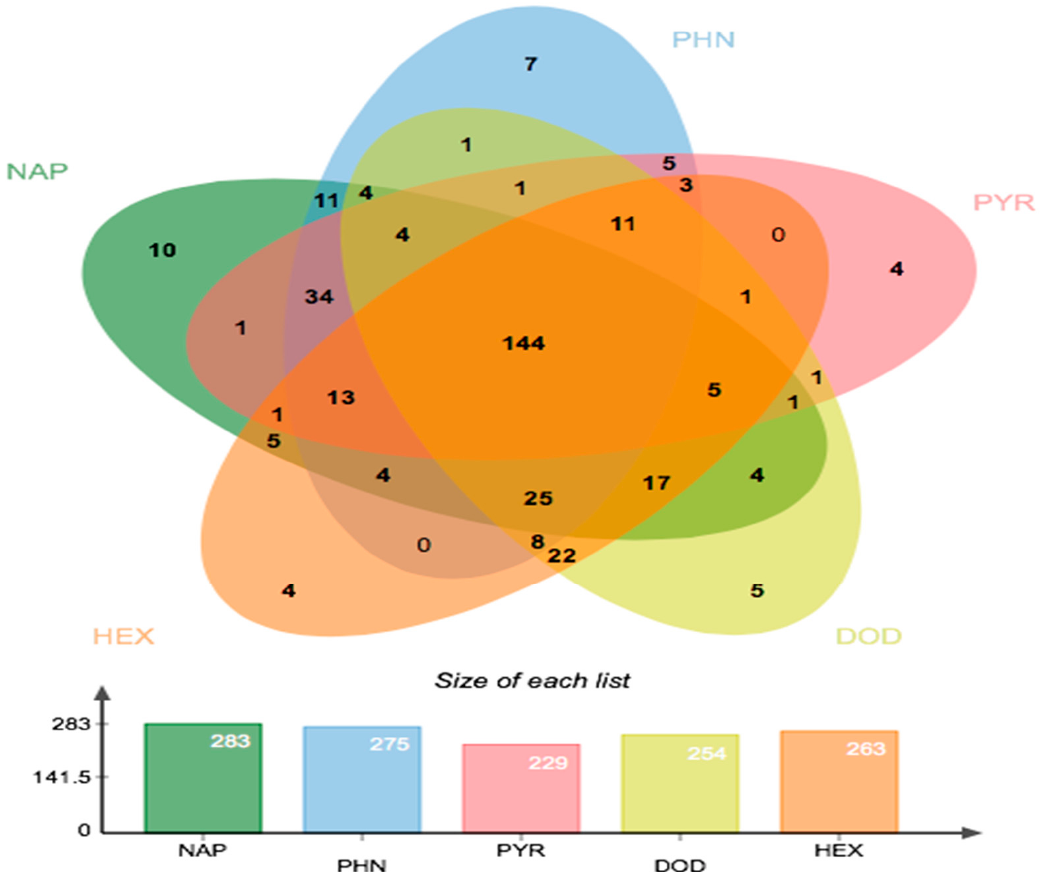
Figure 4. Bacterial isolates that were able to grow with various petroleum hydrocarbons as the only carbon source, showing degradation potential. (Above) Venn-diagram showing the number of isolates that grew on one or many of the five (PHC) compounds. (Below) Bar graph indicating the absolute numbers of bacterial isolates that grew on each of the (PHC) compounds under investigation.